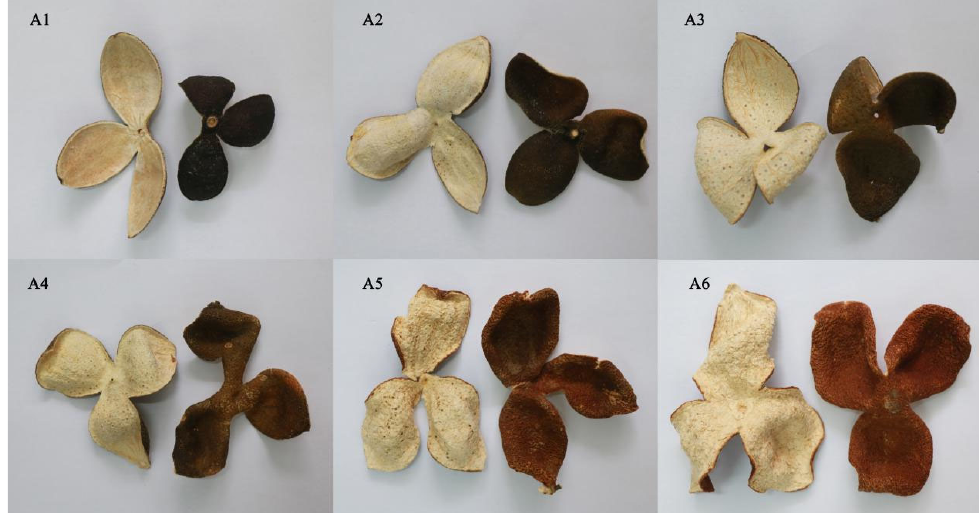
Figure 14. Images of the PCR samples. The plots represent the following: ( A1 ) CRPV (Citri Reticulatae Pericarpium Viride) that was harvested and processed in July is cyan black; ( A2 ) CRPV that was harvested and processed in August is bluish brown; ( A3 ) CRPV that was harvested and pro ‐ cessed in September is blue; ( A4 ) reddish PCR that was harvested and processed in October is yel ‐ lowish brown; ( A5 ) reddish PCR that was harvested and processed in November is yellowish brown; ( A6 ) red PCR that was harvested and processed in December is red brown.